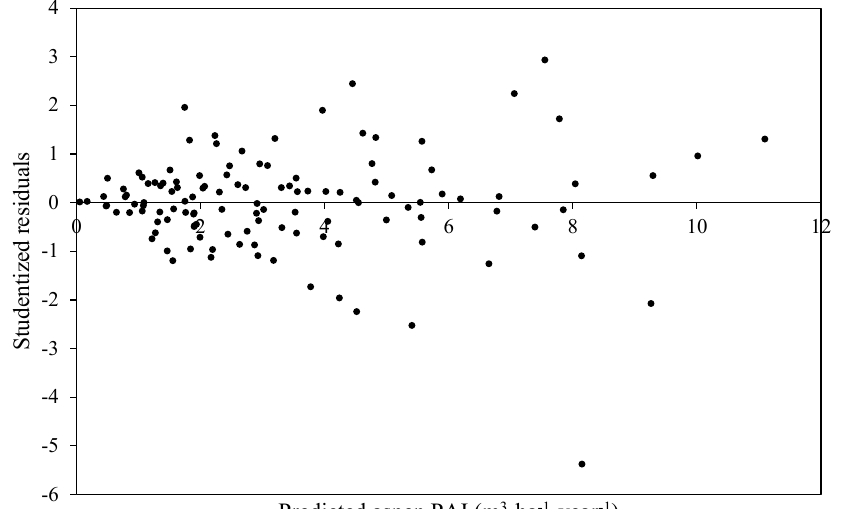
Figure 1. Residuals for the best model for trembling aspen PAI: PAIV aw = β 0 × TPH decβ1 × HT swβ2 × HT awβ3 .